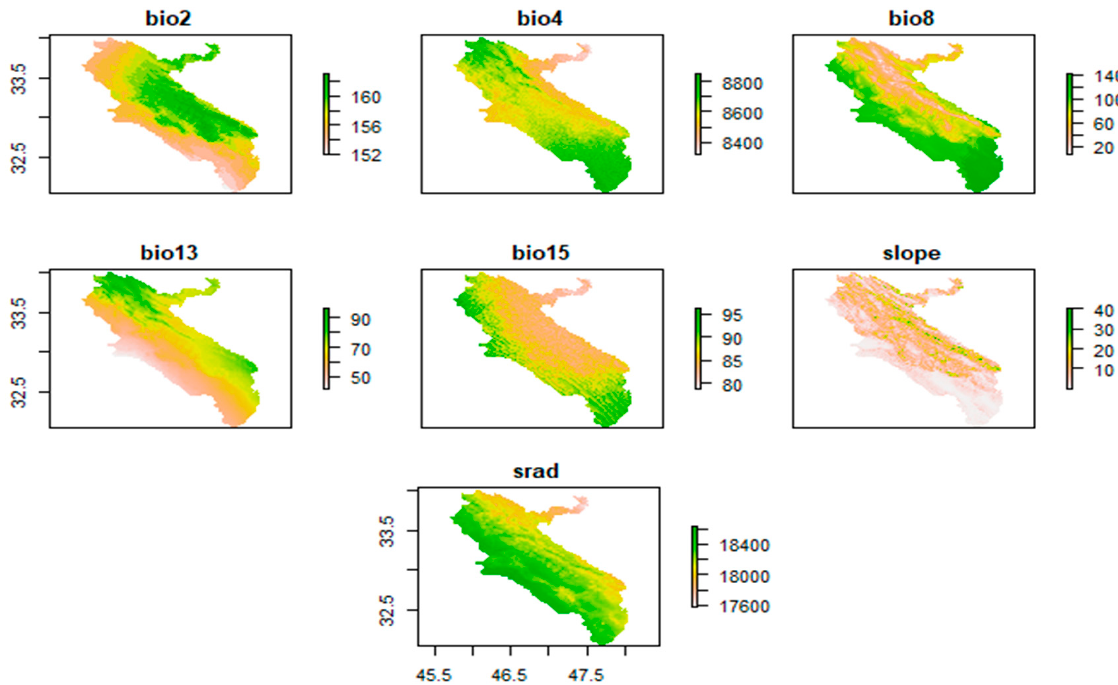
Figure 2. Environmental variables used for modeling the distribution of Quercus brantii in the west of Iran.